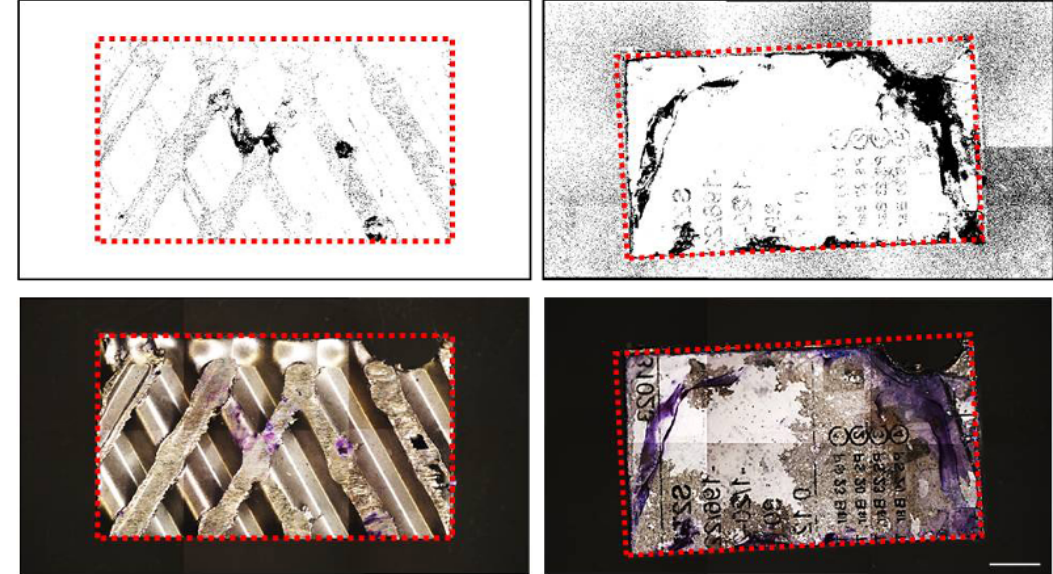
Figure 3. Upper panel: Mosaic images acquired by the motorized stereo zoom microscope AxioZoom V.16 (Zeiss) of two different surfaces of medical devices. Multiple images of the large samples were merged with ZEN Pro software. Lower panel: color deconvolution estimation of the original images stained with crystal violet, in purple. Dotted line shows the area of interest. Scale bar = 5000 μ m; Magnification = 11.2×. Table 1. ImageJ quantification of the crystal violet positive area of eight specimens of contaminated heat exchanger (Samples 1–8). Results on negative controls were obtained by omitting bacteria strains (Samples 9–16). Column 1 shows sample identity numbers. Column 2 reported total crystal violet positive area expressed in pixel 2 . Column 3 represents total crystal violet positive area expressed in mm 2 . Column 4 reports the ratio between crystal violet positive area (expressed in mm 2 ) and the heat exchanger total area (expressed as percentage). CV: crystal violet.